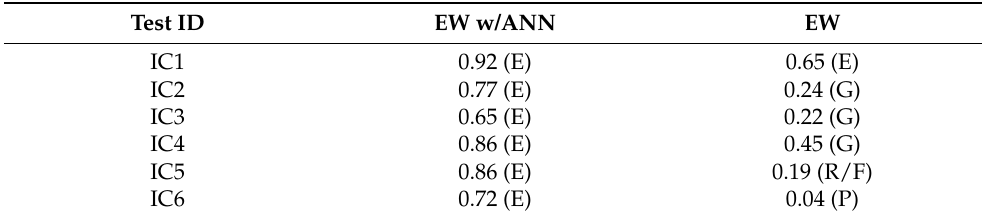
Table 5. Calculated BSS and classification of the “EW w/ANN” and “EW” simulation sets. Test